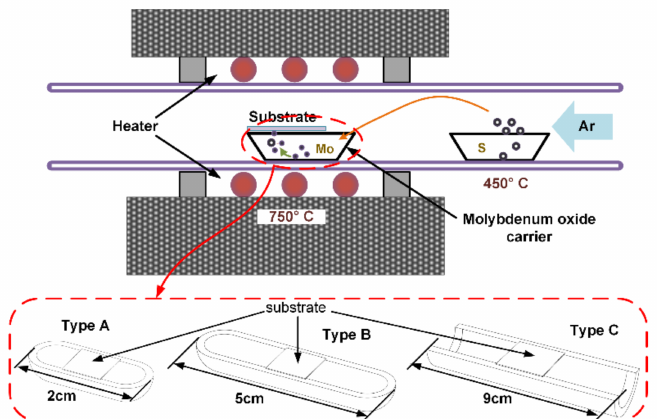
Figure 1. Sketch diagram of the experiment setup of MoS 2 CVD (not to